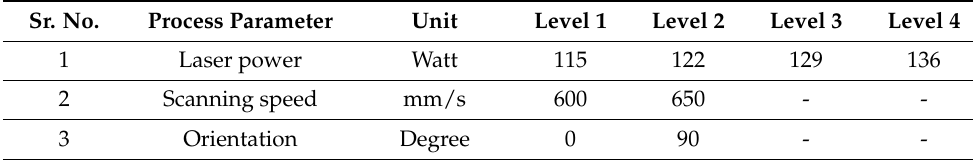
Table 3. Levels of process